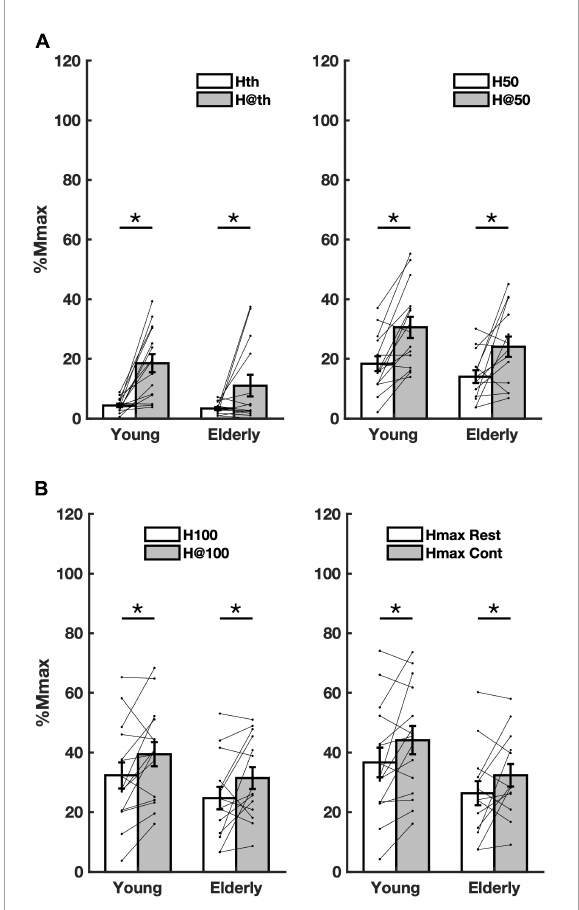
FIGURE1 Overall averaged amplitude parameters from both groups in both conditions. (A) amplitude parameters Hth (rest), H@th (contraction), H50 (rest), and H@50 (contraction) extracted from the recruitment curve (RC) sigmoidal fit; (B) the same as in panel A for the parameters H100, H@100, and Hmax at rest and during contraction. Asterisks mean significant difference ( p < 0.05) between conditions rest (Rest) and contraction (Cont).